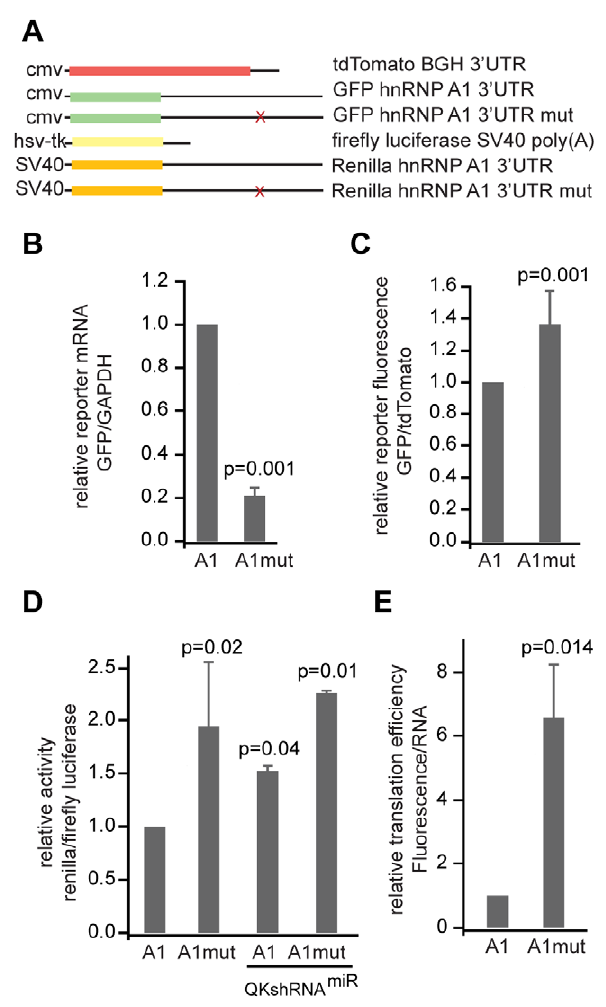
Figure 3. QK controls reporter expression through the QSBE in the Hnrnpa1 3 9 UTR. (A) Constructs used in reporter assays. The Hnrnpa1 3 9 UTR or the Hnrnpa1 3 9 UTR with the U to G point mutation was inserted into the 3 9 UTR of phrGFPII-1. tdTomato was unmodified and served as a transfection control. For the luciferase assays, the firefly luciferase transfection control was encoded on the same plasmid as the experimental Renilla luciferase. The wild type or mutant Hnrnpa1 3 9 UTR was cloned behind Renilla . (B) Two color fluorescence reporter assays conducted with the Hnrnpa1 3 9 UTR and the U-to-G QSBE point mutation. (B) RNA level and (C) reporter fluorescence were assayed as in Figure 1. The RNA data represent the average and standard deviation of nine replicates from three independent experiments. The fluorescence data represent the average and standard deviation of 27 replicates from 9 independent experiments. (D) Dual luciferase reporter experiments, where the wild type or U-to-G point mutant Hnrnpa1 3 9 UTR was inserted into the 3 9 UTR of Renilla reniformis luciferase, and Firefly luciferase expressed from the same vector served as a transfection efficiency control. The dual reporter was transfected into CG-4 cells or a CG-4 cell line that stably expresses a Qk shRNA miR . The relative activities of firefly and Renilla luciferase were determined using a plate reader. Error bars indicate the standard deviation of five independent replicates for the CG-4 cells or variance of two replicates for the shRNA miR cell line. (E) GFP reporter translational efficiency was determined by dividing the relative amount of reporter protein by the relative amount of reporter mRNA. The error was propagated from the standard deviations in (B) and (C) as in Figure 1 and as described in